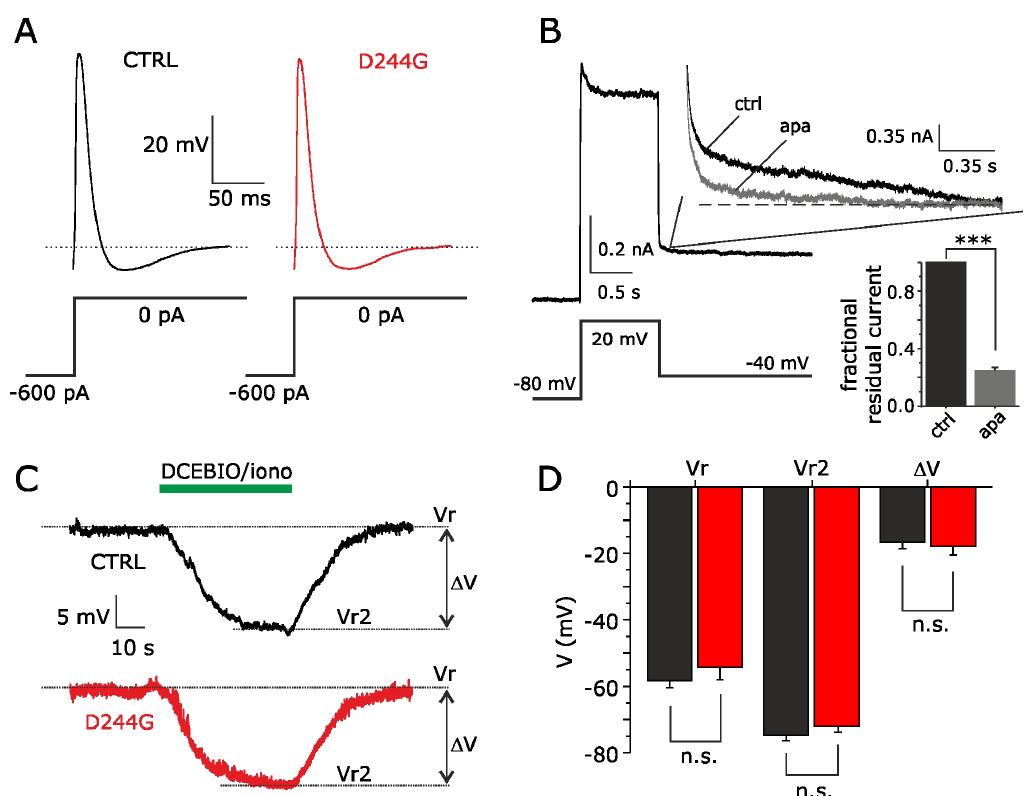
Fig 4. Recordings of action potentials and SK type Ca 2+ -activated K + currents from myotubes. ( A ) Rebound APs elicited by a hyperpolarizing current (-600 pA, 500 ms), followed by a pulse to zero current injection, in sample myotubes from a patient ( red ) and a control ( black ). ( B ) Currents, elicited in a control myotube by a pre-pulse to +20 mV, followed by repolarization to -40 mV. Tail currents are shown enlarged before ( ctrl ) and after apamin ( apa ) application (100 nM). The bar graph ( inset ) shows the fractional tail current before and after apamin application. ( C ) Membrane voltage traces recorded from sample control ( black ) and patient ( red ) myotubes, showing the hyperpolarizing effect of co-application of 100 μ M of the SK channel activator DCEBIO and 2 μ M of the Ca 2+ ionophore agent ionomycin (indicated as DCEBIO/iono) in the recording chamber, without applying holding current. ( D ) Plot showing the mean membrane potential before (Vr) and after (Vr2) bath application of DCEBIO/iono, and the mean DCEBIO/iono induced hyperpolarization ( Δ V) in control ( black ) and patient ( red ) myotubes. The data are mean ± SEM; n = 6.